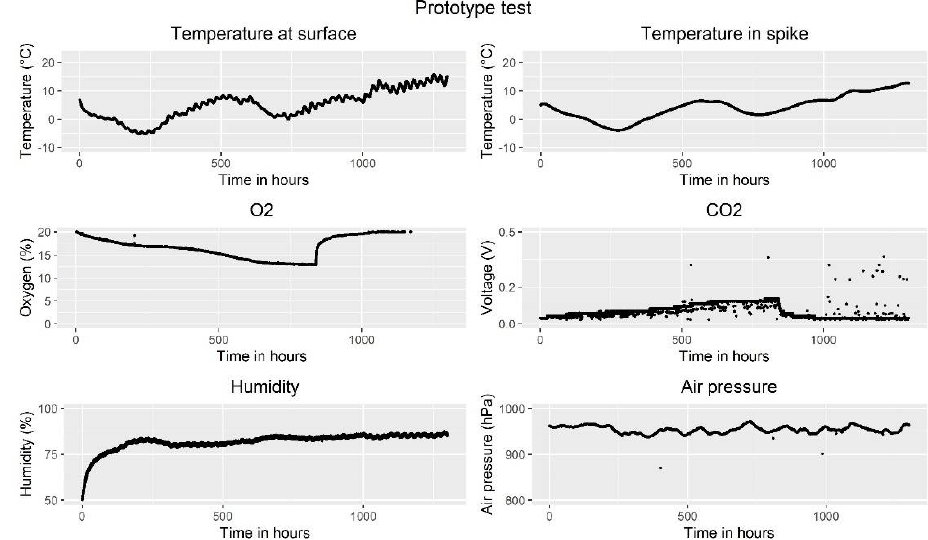
Figure 7. Results of the prototype test with already-fermented silage. Silage was extracted from a full-scale silo and re-ensiled in the test silo in winter. Temperatures at surface and in spike show the same patterns. At the surface daily variations are also seen. Oxygen decreases during the trial, while carbon dioxide rises. Both processes reverse as the test silo is opened. Humidity rises over the whole period, and air pressure shows no anomalies when compared with outside air pressure.